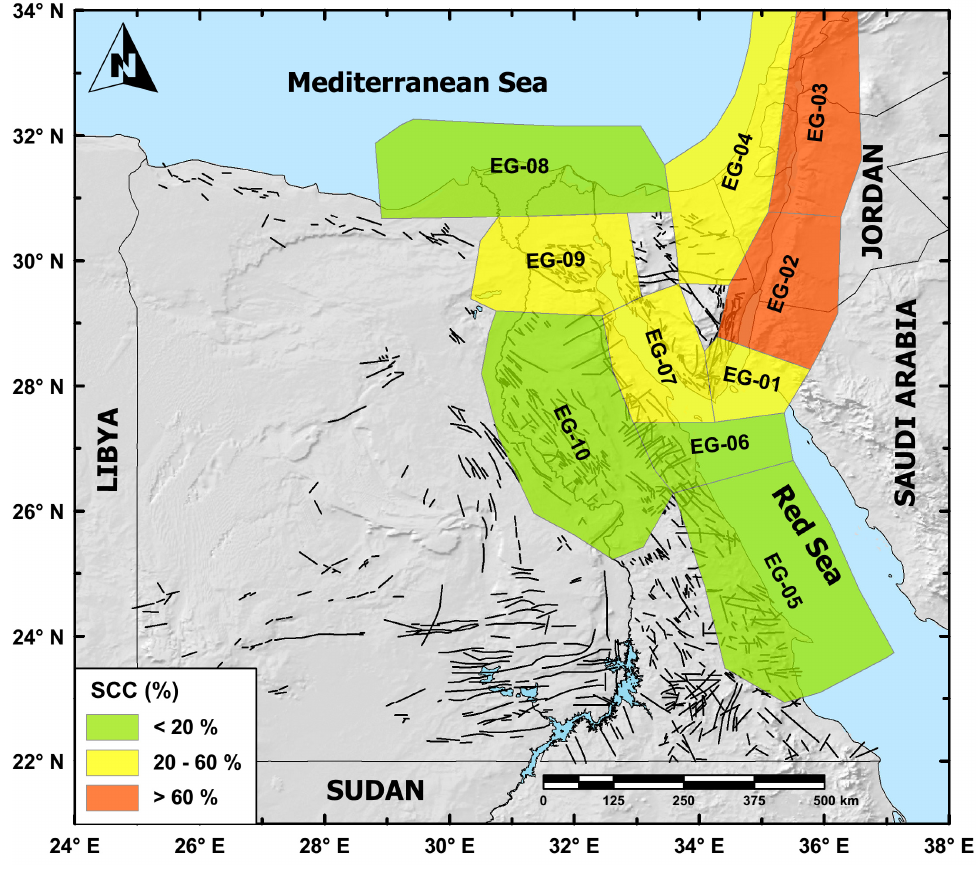
Figure 8. Seismic coupling coefficient (SCC) is depicted as percentage of the seismic-geodetic moment-rate ratio. moment-rate